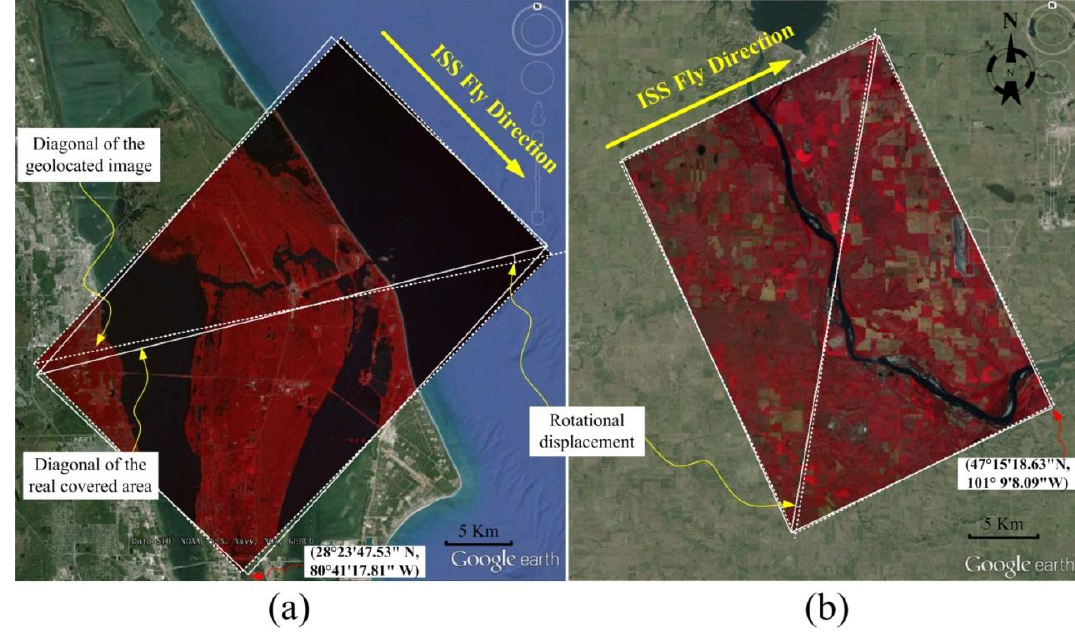
Figure 7. Two images acquired ( a ) over Kennedy Space Center, Florida at 13:06:28:52 (hh:mm:ss:ms) on 5 August 2011 (local time) with a sensor tilting angle of −24.729° and ( b ) over Stanton, North Dakota at 18:06:20:57 on 9 September 2011 with a tilting angle of 21.163° are overlaid onto the Google Earth TM . In each panel, the rectangle in dashed lines denotes the outline of the geolocated image after applying Dou et al. [8] geolocation algorithm; the rectangle in solid lines denotes the outline of the image that would match the Google Earth TM exactly. The angle formed by the diagonals of the two rectangles (measured from the dashed line to solid line) is the rotational displacement, which is counter-clockwise for descending orbit in (a) and clockwise for ascending orbit in (b). Since the Kennedy Space Center (28°23ʹ47.53ʹʹN, 80°41ʹ17.81ʹʹW) is closer to the Equator than Stanton (47°15ʹ18.63ʹʹN, 101°9ʹ8.09ʹʹW), the rotational displacement angle